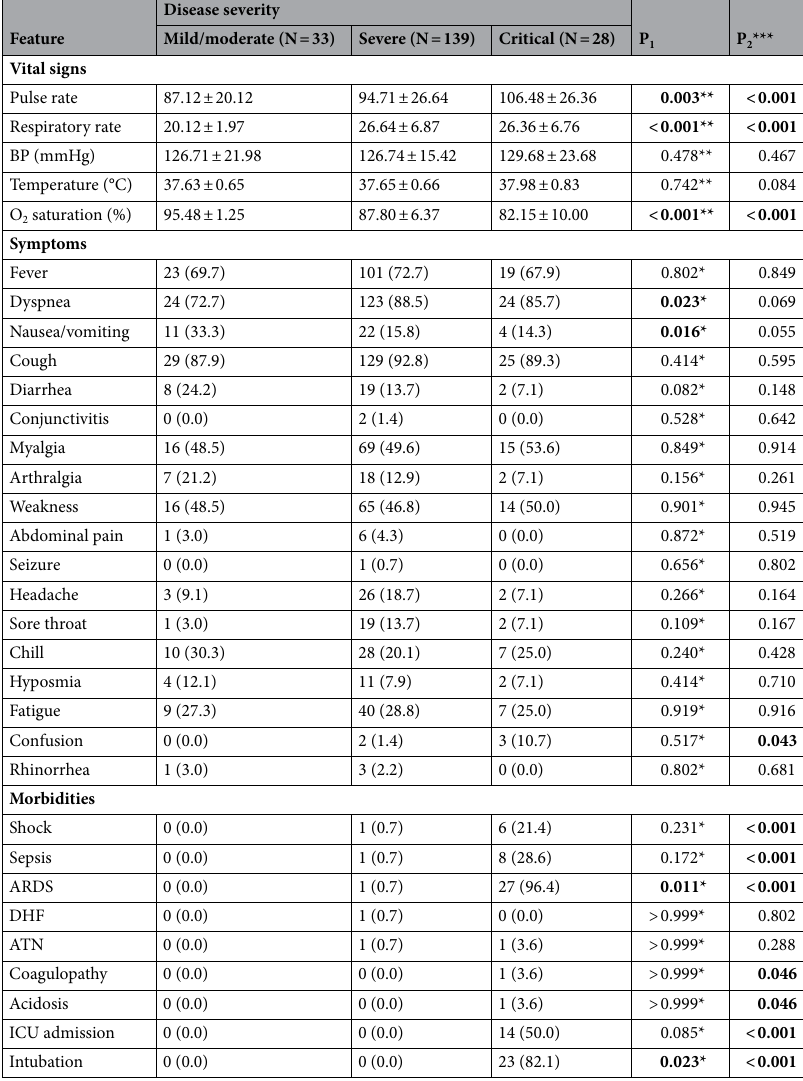
Table 2. Vital signs, clinical symptoms, and morbidities in patients with different disease severities. BP blood pressure, ARDS acute respiratory distress syndrome, DHF diastolic heart failure, ATN acute tubular necrosis, ICU intensive care unit. P 1 : Comparison between mild/moderate and severe/critical groups. P 2 : Comparison between mild/moderate, severe, and critical groups. Bold values are statistically significant (P < 0.05). *Chi- square or Fisher’s exact test. **Mann–Whitney test. ***Kruskal–Wallis